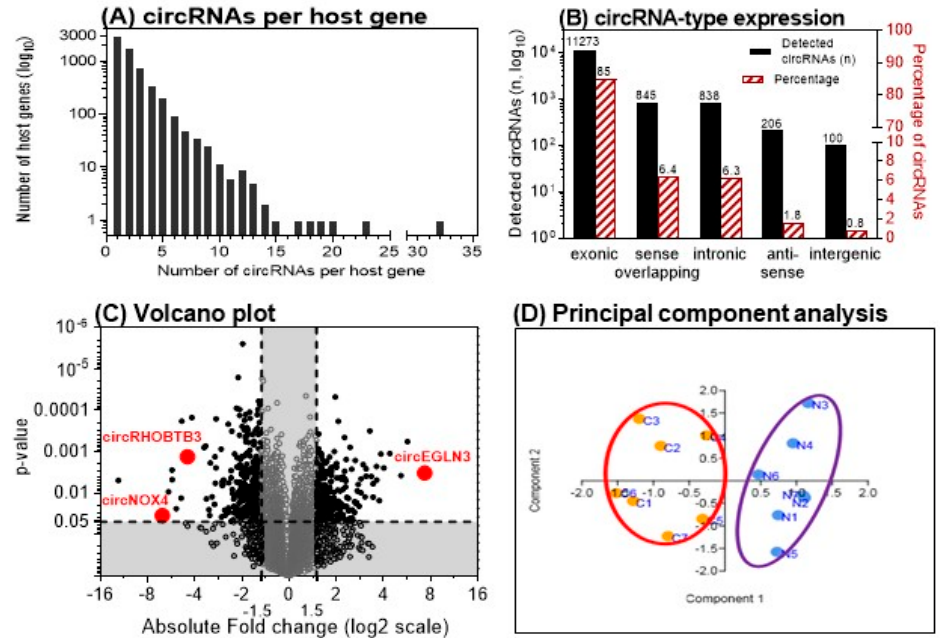
Figure 2. Microarray analysis results of matched clear cell renal cell carcinoma (ccRCC) tissue samples. ( A ) Number of circular RNAs (circRNAs) expressed per host gene in 7 matched ccRCC tissue samples. ( B ) Genomic origin of the detected circRNAs. ( C ) Volcano plot showing the up- and down-regulated circRNAs in malignant vs. adjacent normal tissue samples. Vertical and horizontal dashed lines indicate the thresholds of the 1.5-fold changes and the p -values of 0.05 in the t -test. The positions of the three detailed examined circRNAs in this study are marked. ( D ) Principal component analysis with the left cluster of tumor samples (C1–C7) and the right cluster with the paired adjacent normal tissue samples (N1–N7). (A and B adapted from [12]).